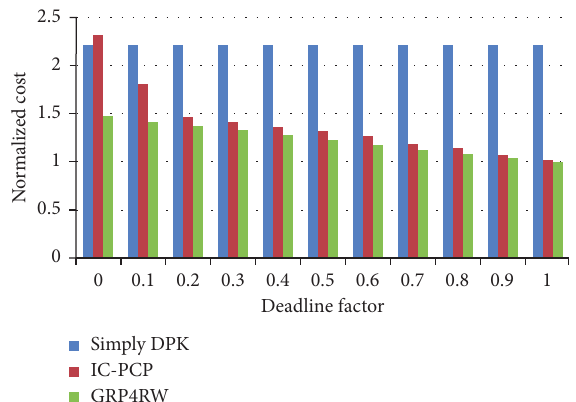
Figure 6: Normalized cost of large size workflow with simply DPK, IC-PCP, and